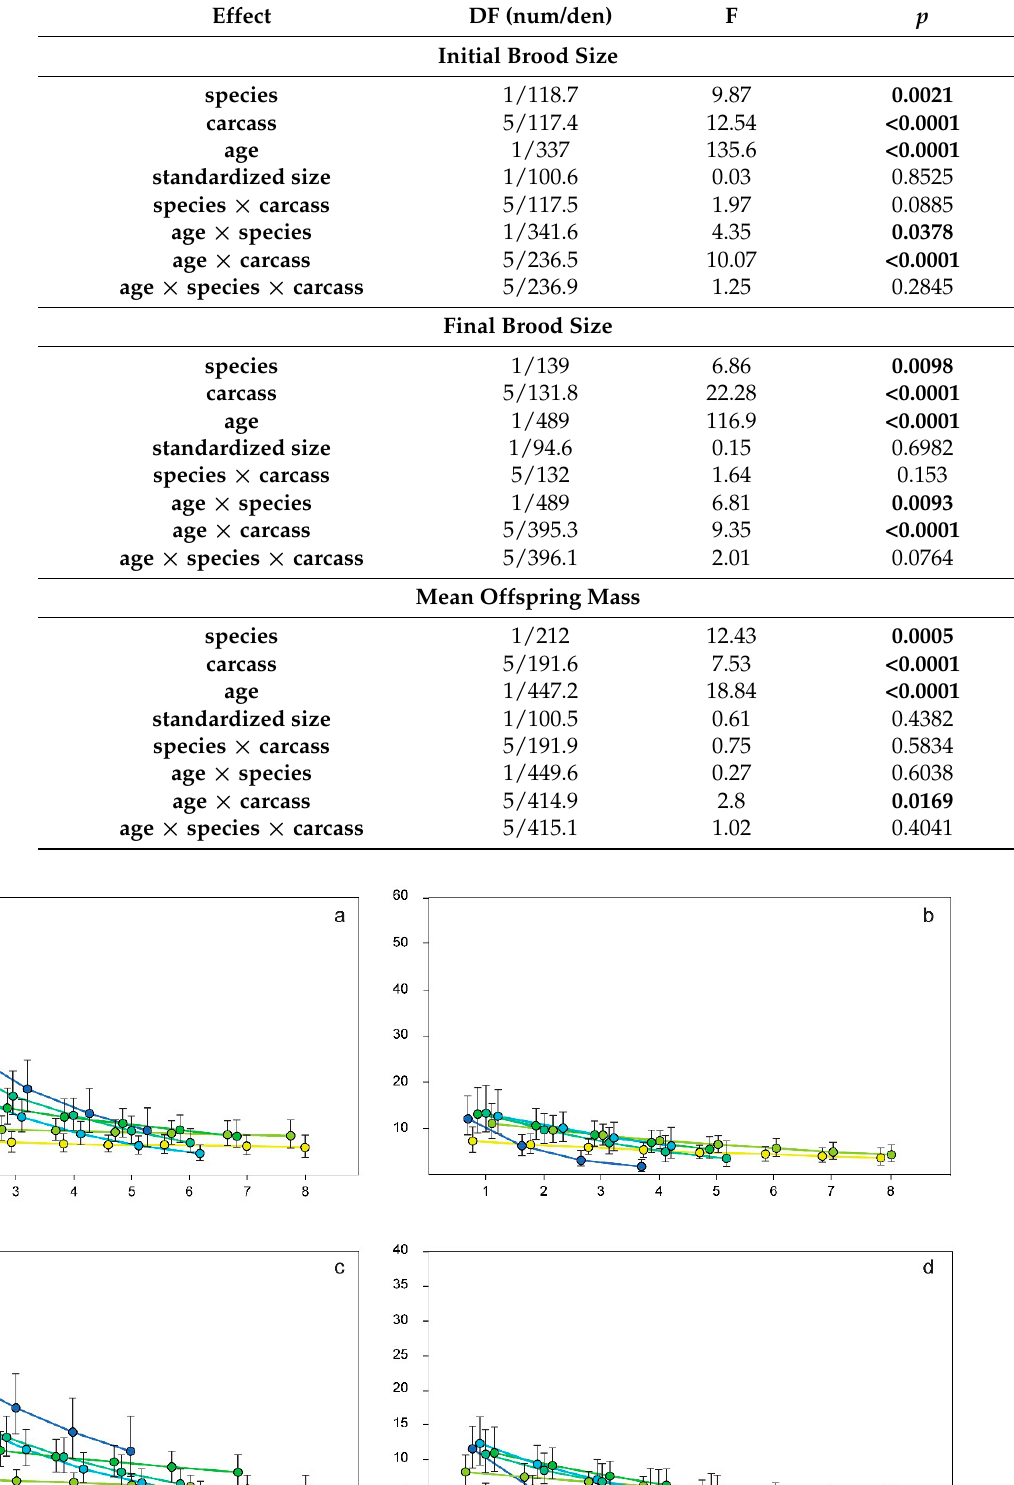
Table 5. Results of repeated measures ANCOVA for initial brood size, final brood size, and mean offspring mass. Significant effects are bolded.